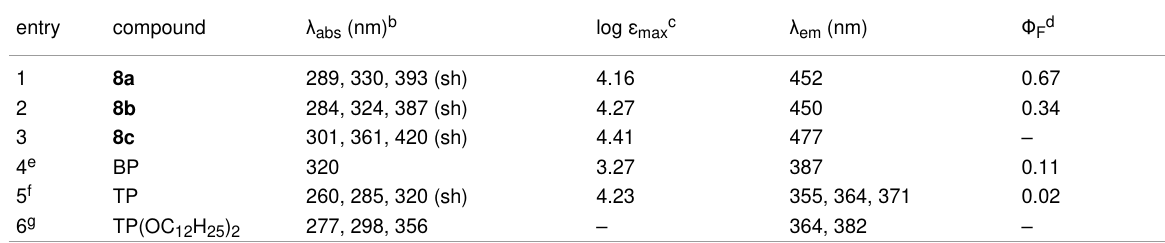
Table 1: Summary of the absorption and emission spectra. a